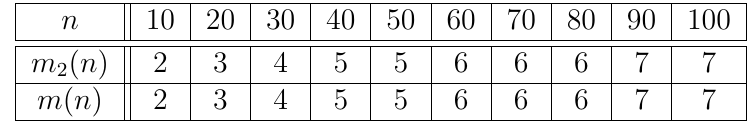
( n ) (resp. m ( n )) of forcibly biconnected (resp. con- 2